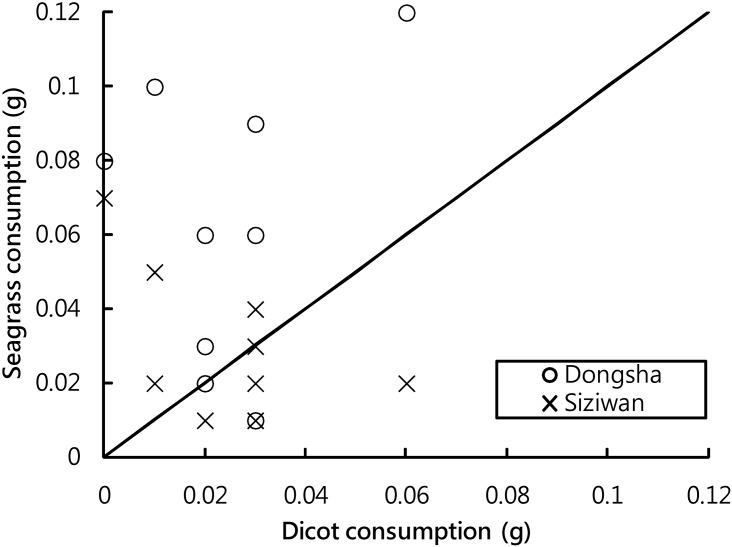
Coenobita rugosus. Results of food preference test of hermit crabs collected from Dongsha and Siziwan.A significant difference was found in the Dongsha crabs but not in the Siziwan crabs (P = 0.015 and P = 0.83, respectively, Wilcoxon signed-rank test). The diagonal line indicates a 1:1 dietary consumption.